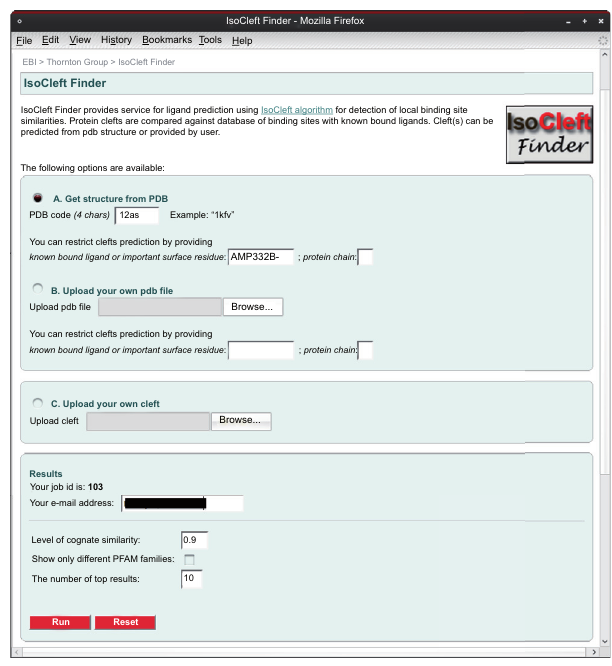
Figure 3. IsoCleft Finder input page showing the different options to upload or define the query cleft.